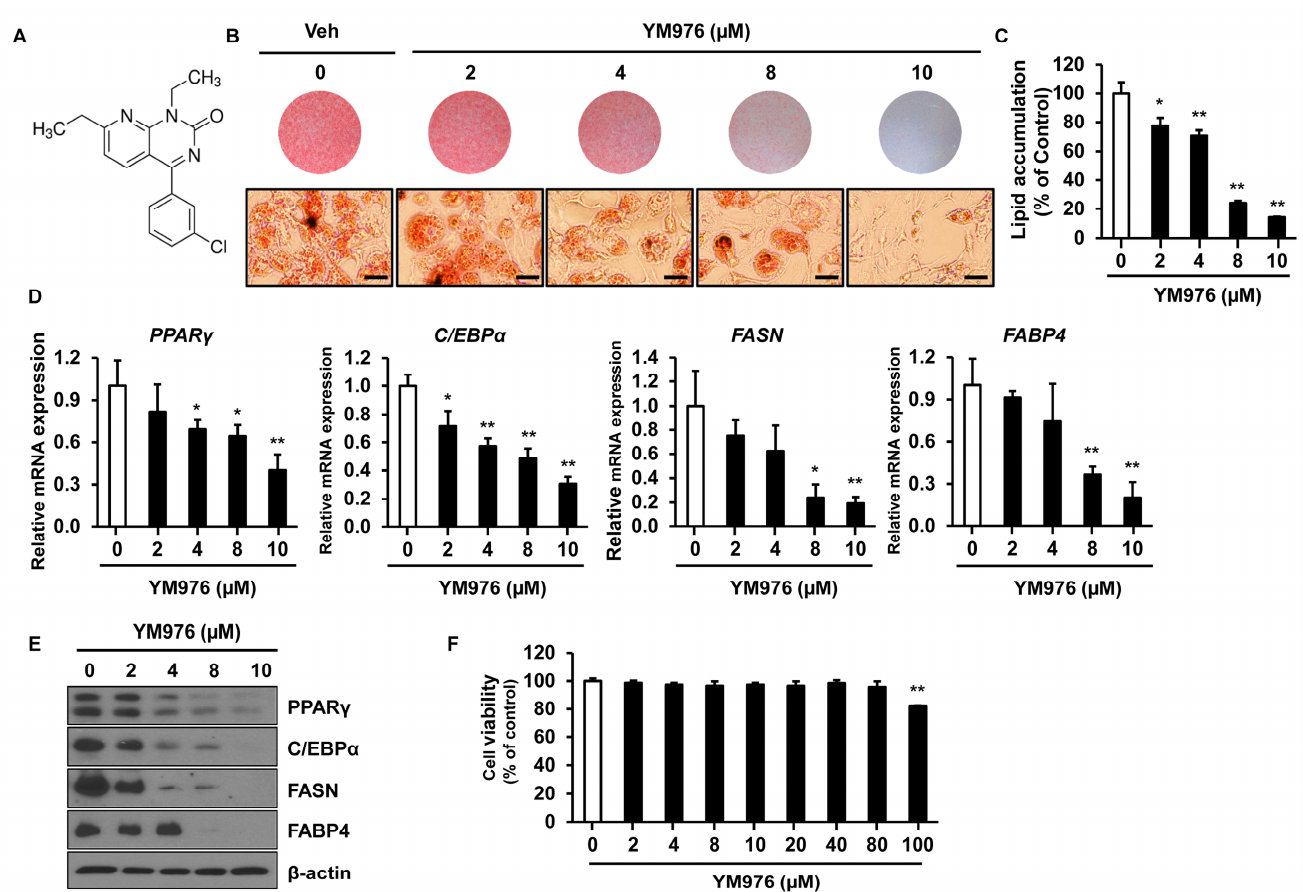
Figure 1. YM976 inhibits adipocyte differentiation. ( A ) The chemical structure of YM976. ( B ) 3T3-L1 cells were induced to differentiate for six days and treated with Veh or various concentrations of YM976. Microscopic image after staining with Oil Red O. Scale bar = 100 µm. ( C ) Quantification of Oil Red O staining by spectrophotometry. ( D ) The mRNA expression of PPARγ, C/EBPα, FASN, and FABP4 in cells after treatment with various concentrations of YM976 was analyzed by qRT-PCR. ( E ) Protein levels of PPARγ, C/EBPα, and C/EBPβ were analyzed by Western blot. ( F ) The effect of YM976 on cell viability. In ( C – E ), n = 3 per group. Images and blots are representative of three independent experiments. Values indicate mean ± SD. * p < 0.05; ** p < 0.01. Data were assessed by one-way ANOVA with Dunnett’s post hoc test.